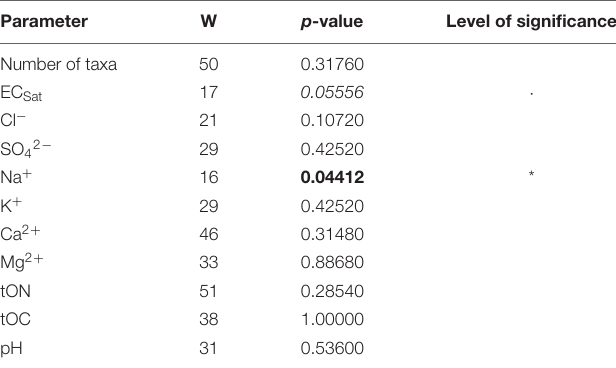
TABLE 3 | Results of screening for significant differences between young and established biocrusts regarding number of algae taxa (culture-dependent approach) and environmental parameters, by Man-Whitney U Test.